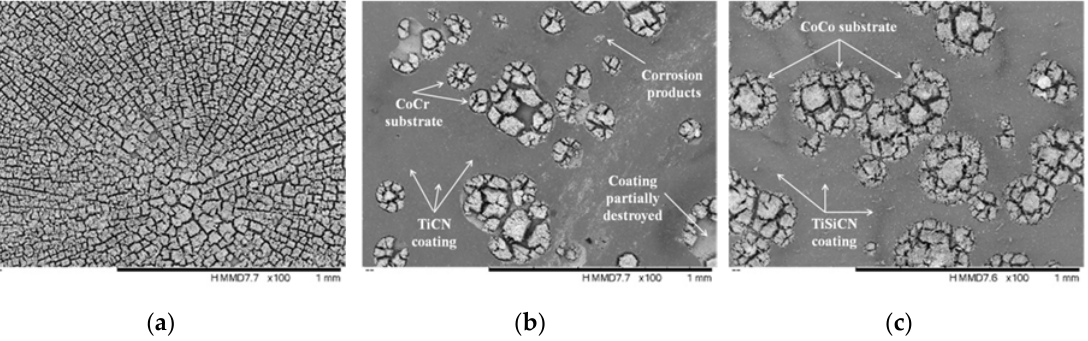
Figure 6. SEM of the investigated ( a ) CoCr substrate and ( b ) TiCN and ( c ) TiSiCN coatings.